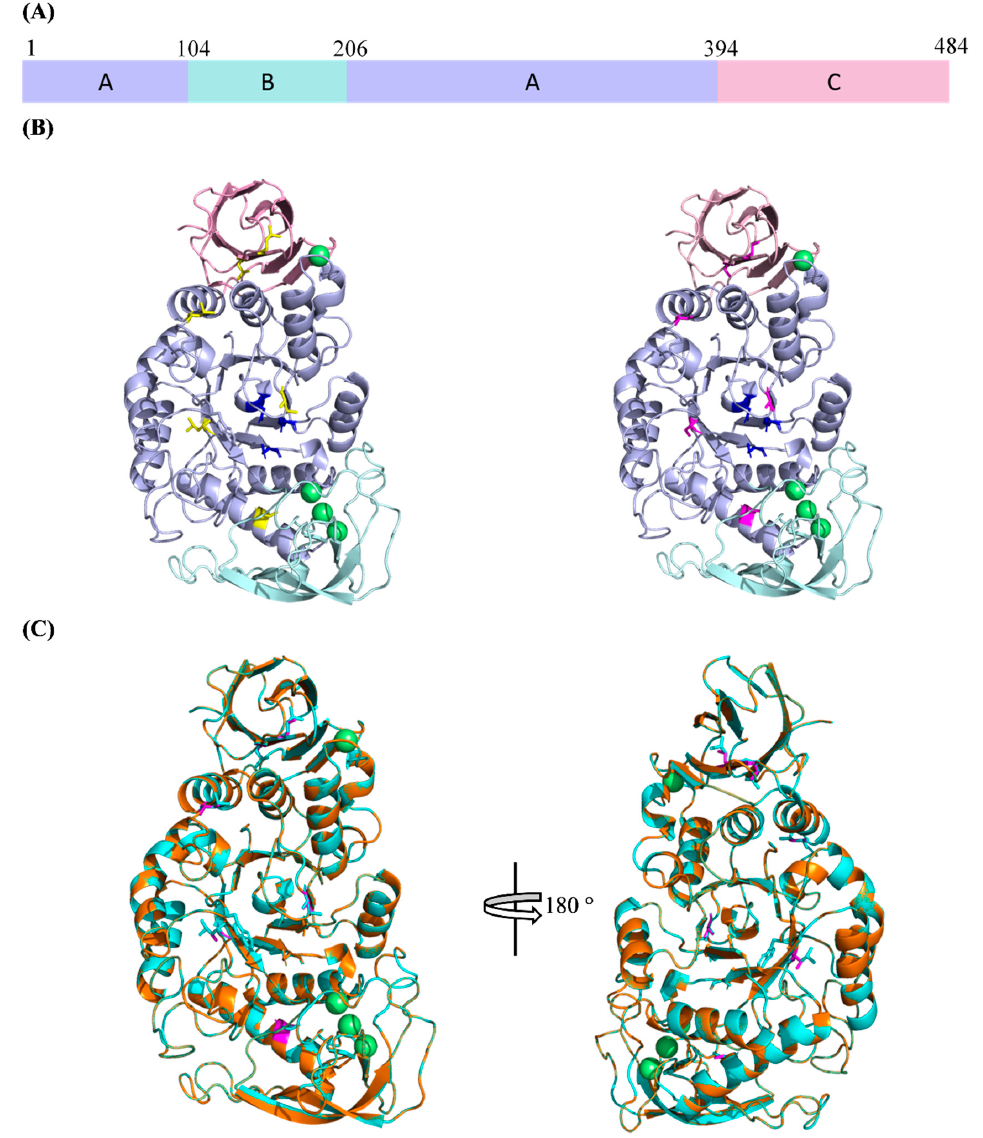
Figure 2. The 3D structures of WT and rc SR74 α -amylases predicted using SWISS-MODEL. ( A ) Domain arrangement of SR74 α -amylases. Domains A, B and C are colour-coded and the domain boundaries are shown; ( B ) the predicted 3D structures of SR74 α -amylases. WT SR74 α -amylase with yellow-coloured leucine residue (left), rc SR74 α -amylase with magenta-coloured serine residue (right). Catalytic triad (D234, E264, D331) are blue-coloured and calcium ions (Ca 2 + ) are in green. ( C ) The superimposition of both WT and rc SR74 α -amylases. Polypeptide chains of WT and rc SR74 α -amylases are coloured with cyan and orange, respectively. The views are related by a 180 ◦ rotation around the vertical axis. All the structural figures are viewed and prepared using the PyMOL Molecular Graphic System, Version 2.4 Schrödinger, LLC.